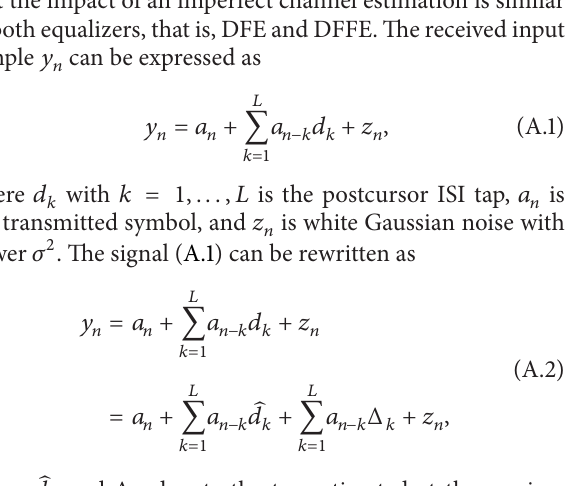
Table 3: Complexity comparison between parallel DFFE and DFE architectures for 𝑀 -PAM with 𝑅 = 𝐿 + 1 for 𝐿 ≫ 1 . Component